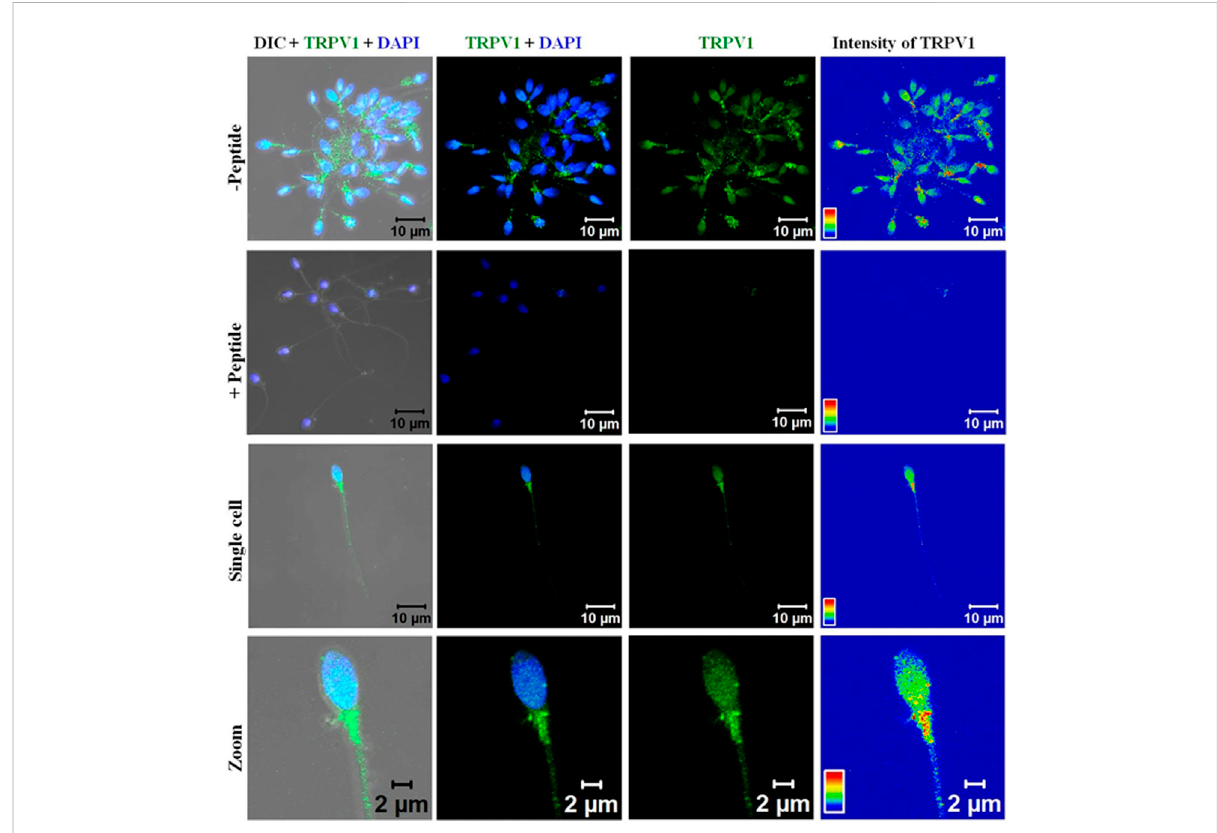
FIGURE 2 Representativeconfocalphotomicrograph(63X)showingimmunocytochemicallocalizationandexpressionpro fi leofTRPV1channel(green)in human sperm. First row (peptide-) sperm cluster in absence of immunizingpeptide showing thepositive stainingof thechannel(green) and counter stained with DAPI; second row (peptide+): sperm cluster in presence of immunizing peptide (blocking the primary antibody) showing spermatozoa unstained for TRPV1 validating the antibody; third row: single sperm; and fourth row: zoomed view of single sperm showing the distribution patternofthechannel);rightcolumnshowingtheintensitycalculation. DIC:differentialinterference contrast;DAPI: 4 ′ ,6-diamidino-2-phenylindole (blue nuclear counter stain). TRPV1 primary antibody (Alomone Labs, #ACC-030) was used at 1:200 dilution. Confocal images were obtained